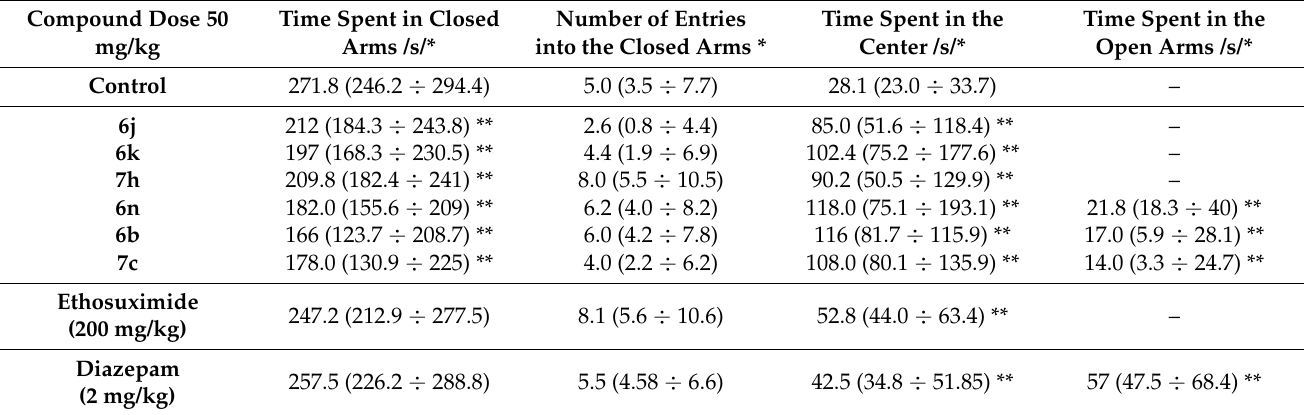
Table 5. Influence of compounds 6b , j , k , n ; 7c , h and compared drugs on the EPM model (5 min of research). Compound Dose 50